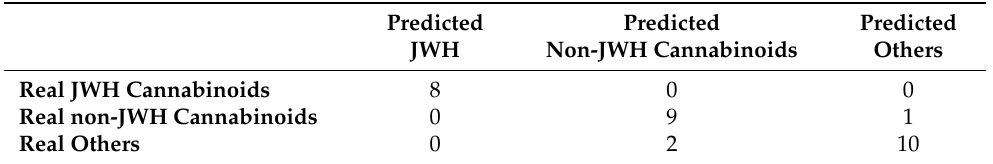
Table 3. Confusion matrix for the analyzed ANN—version 2: 27 (90.0%) tested compounds were correctly classified and 3 (10.0%) were misclassified.